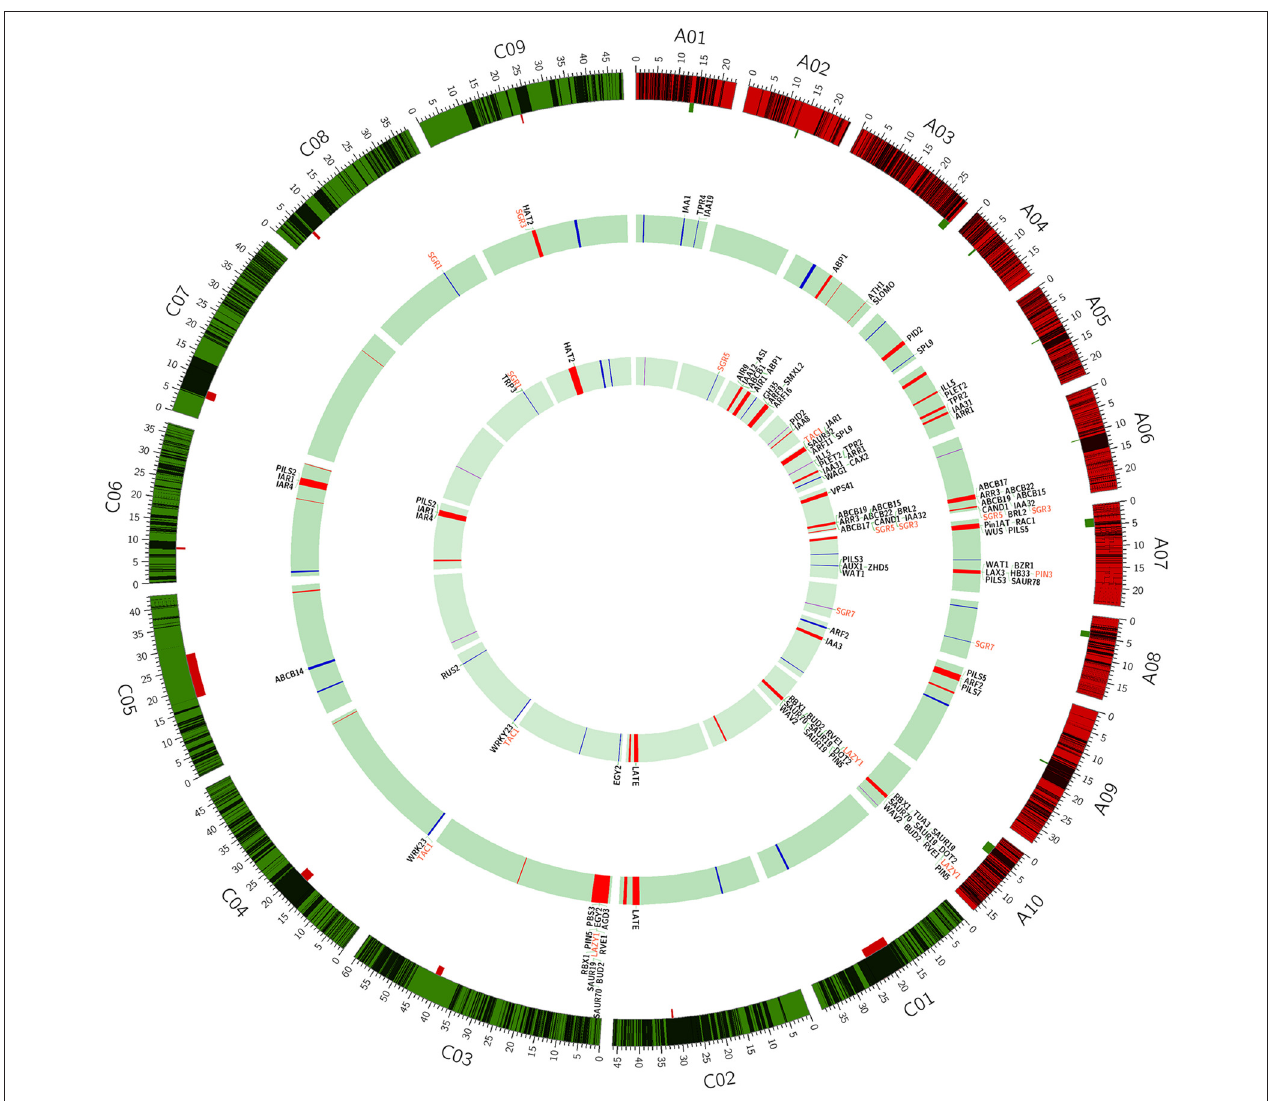
FIGURE 3 | Mapping of haplotype blocks and association loci for branch angle on the Brassica napus genome. The black bands in the outer circle indicate the haplotype blocks; the location, and size of centromeres are marked by the rectangles attached to the outer circle. The bands in the middle and inner circle indicate the association loci for branch angle that are identified in the MLM and MRMLM model, respectively. Three types of loci (QTL, LD block, and no block) are colored in red, blue and violet, respectively. The identified genes are listed on the outside of the middle and inner circles, and the genes of interest are colored in red.